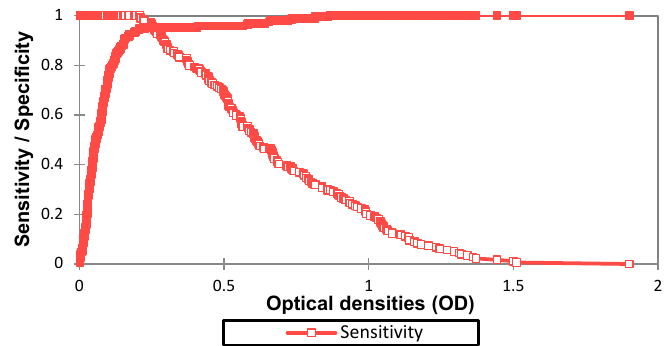
Figure 2. Sensitivity, specificity, TP, TN, FP, and FN per OD value.